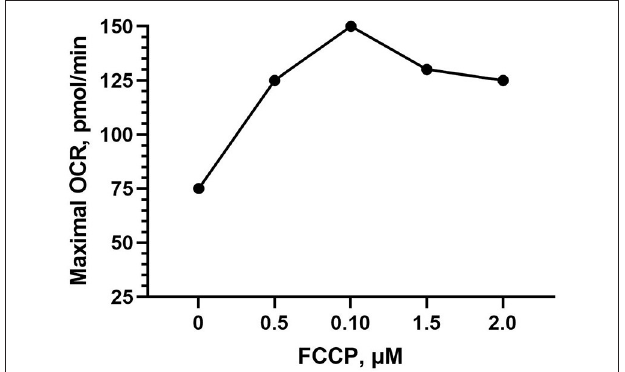
FIGURE 3 | Example carbonyl cyanide-4 phenylhydrazone (FCCP) titration within the Seahorse Cell Energy Phenotype test showing the established effect of a plateau in OCR following peak respiration